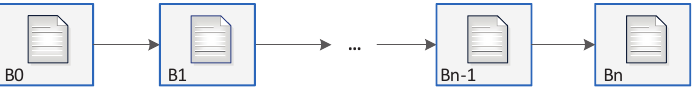
Figure 5. General structure of